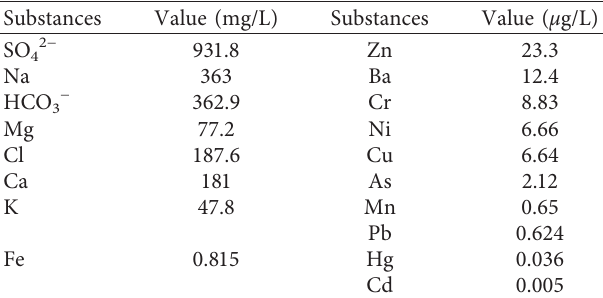
Table 7: Chemical composition of